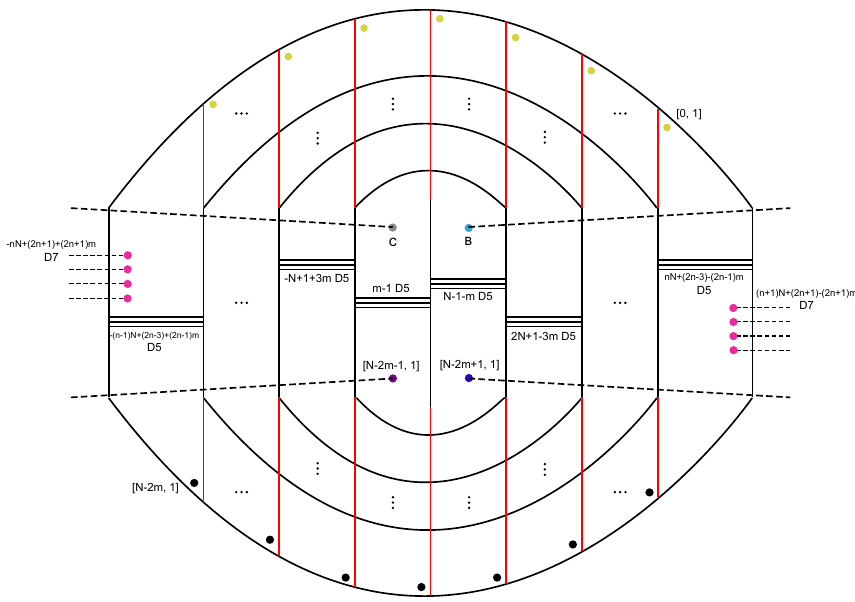
Figure 37 . Diagram after the motion in (cid:12)gure 36.